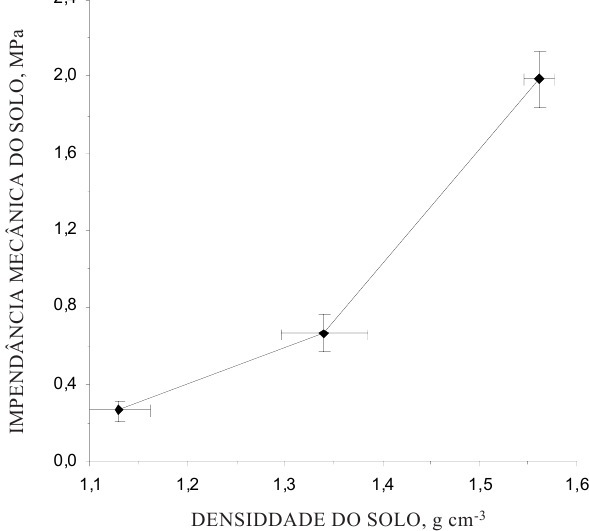
Figura 1. Resistência mecânica à penetração e densidade do solo das diferentes camadas compactadas utilizadas no experimento. Barras verticais e horizontais em cada ponto representam os desvios-padrão das